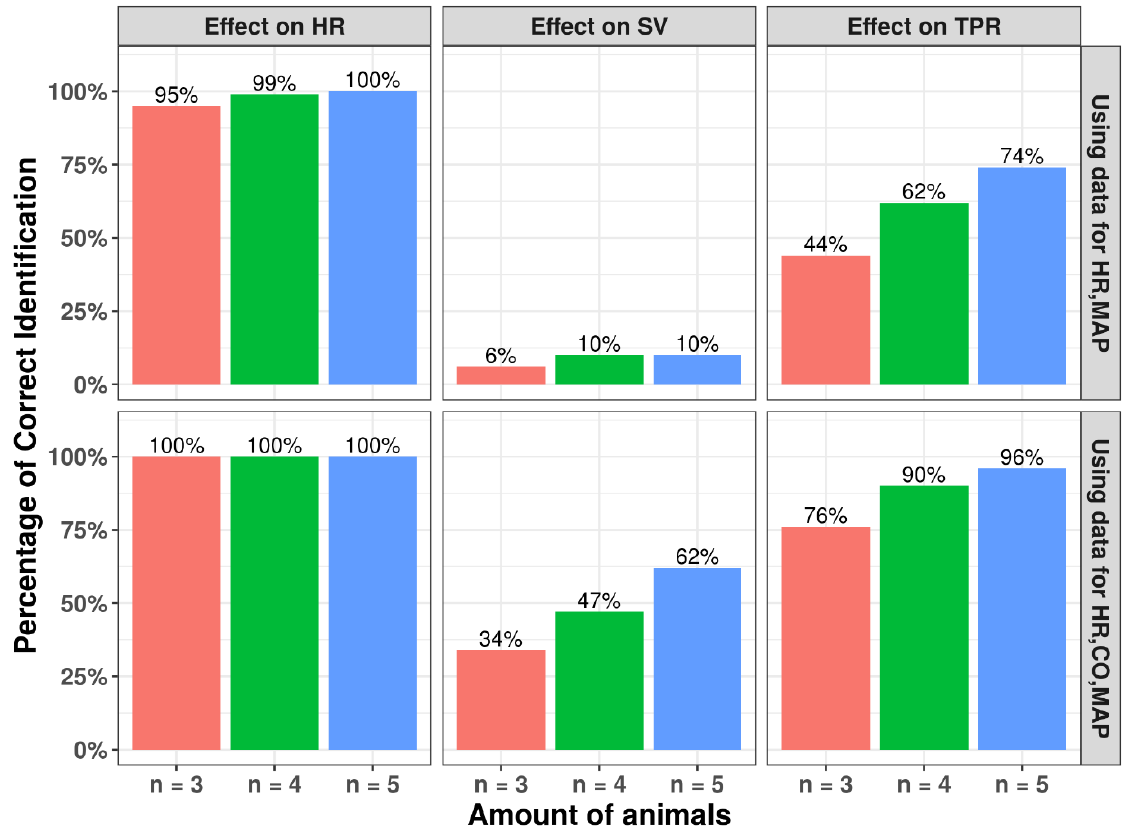
Figure 7. Impact of number of animals used in experiments on percentage of runs with correct identification of mechanism of action. Derived using SSE analyses using data for 3, 4, or 5 animals with observations of HR and MAP or observations of HR, CO, and MAP, while Emax was fixed as −1 and EC 50 was fixed as 100 ug/mL in original model. Correct identification is based on applying a likelihood ratio test compared to the base (no drug) model.